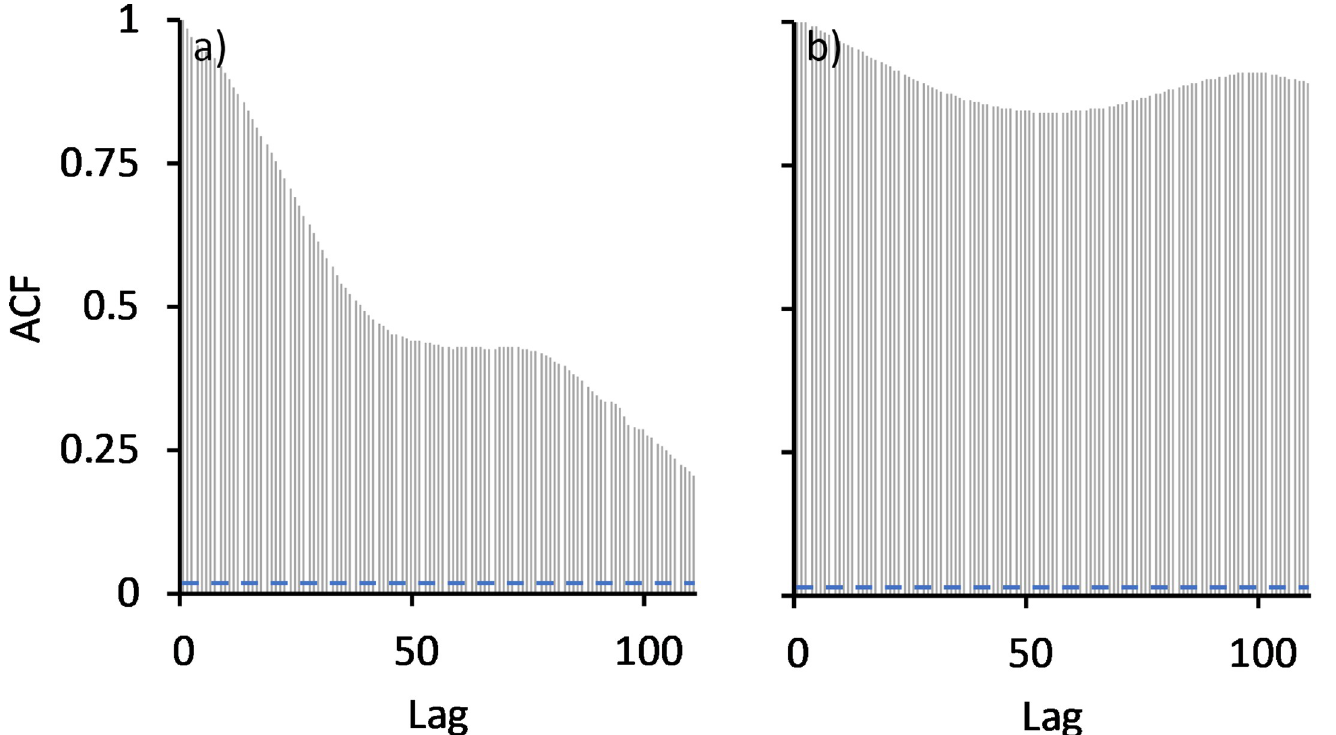
Fig 12. Autocorrelation of DO at the above bund locations, a) before and b) after bund removal. Lag distance here is 15 min with a 24-hr period represented by a lag of